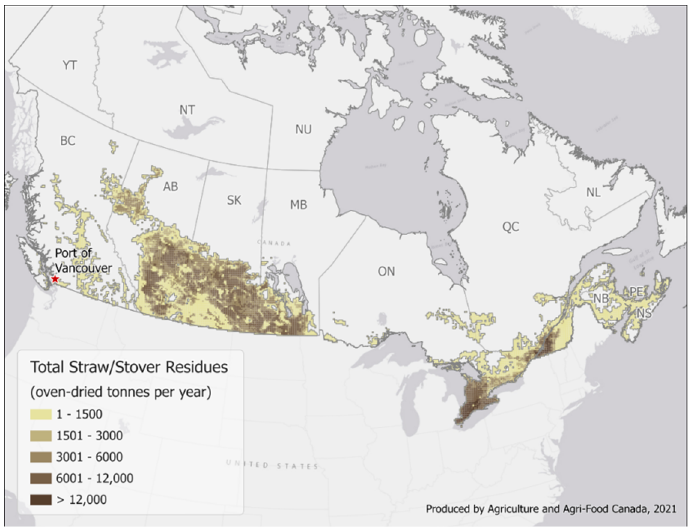
Figure 5. Regional availability of agricultural biomass in Canada [52].